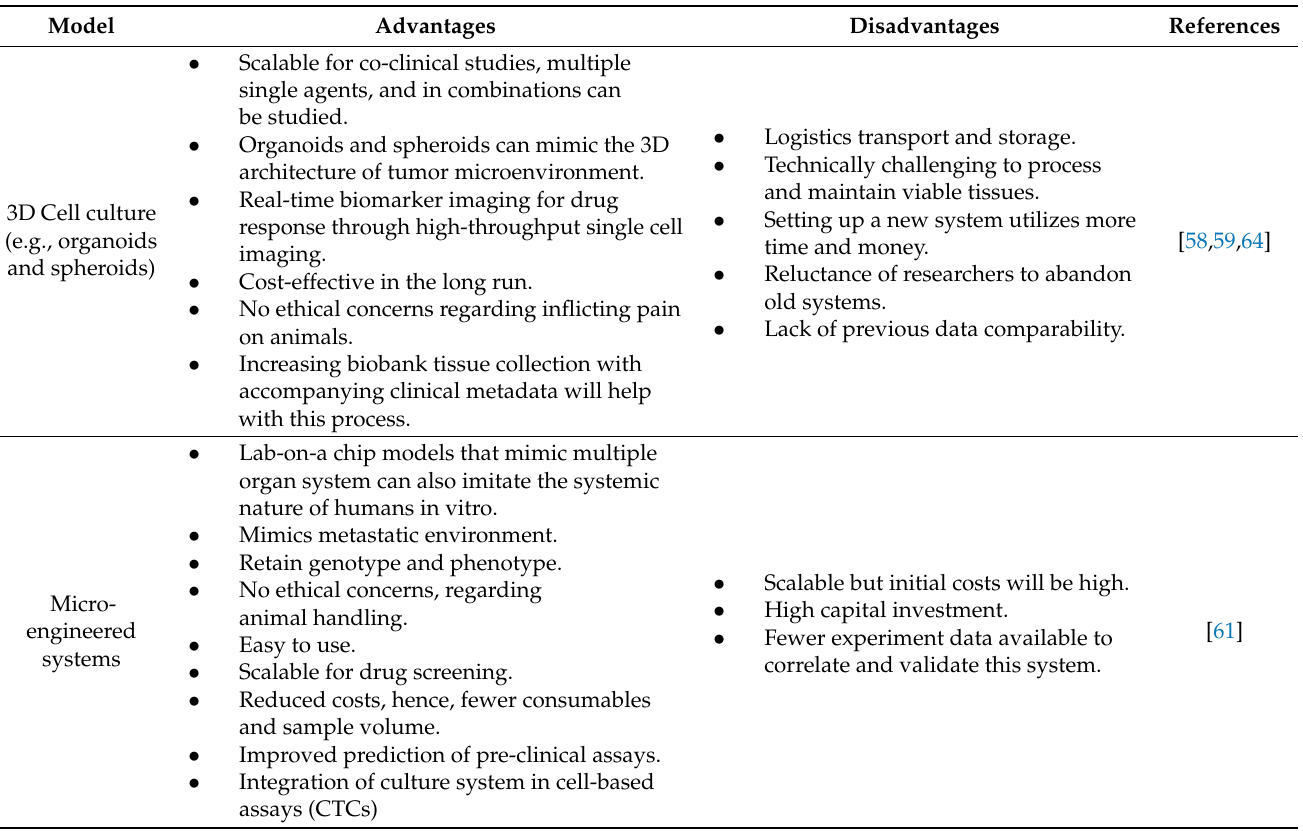
Table 3. Advantages and disadvantages of non-animal models in co-clinical trials.